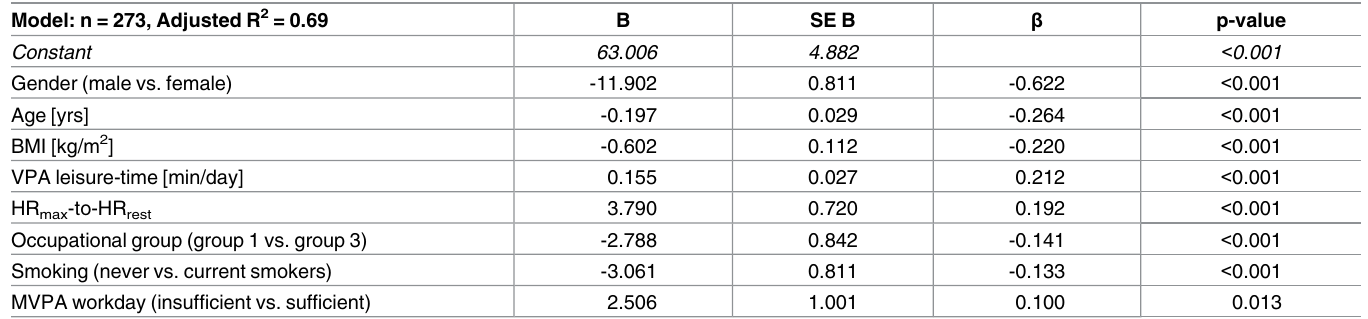
B, unstandardized regression coefficient; β , standardized beta coefficient; BMI, body mass index; HR max -to-HR rest , ratio of maximum to resting heart rate; MVPA workday (insufficient vs. sufficient), comparison of insufficient ( < 30 min per day) to sufficient ( (cid:21) 30 min per day) moderate-to-vigorous physical activity calculated from bouts of (cid:21) 10 min on workdays; Occupational group (group 1 vs. group 3), comparison of group 1 with low occupational physical activity to group 3 with high occupational physical activity; SE, standard error; VO 2max , maximal oxygen consumption during multistage 20-meter shuttle run test; VPA, physical activity duration at vigorous ( (cid:21) 6 METs) intensity. Excluded variables were: AEE / MPA / VPA / Steps during work-time, AEE / MPA / Steps in leisure-time, AEE / MPA / VPA / Steps on non-working days, ex-smokers (vs. never smokers), occupational group 2 (vs. group 1), HR max -to- HR recovery , MVPA non-working days (insufficient vs.